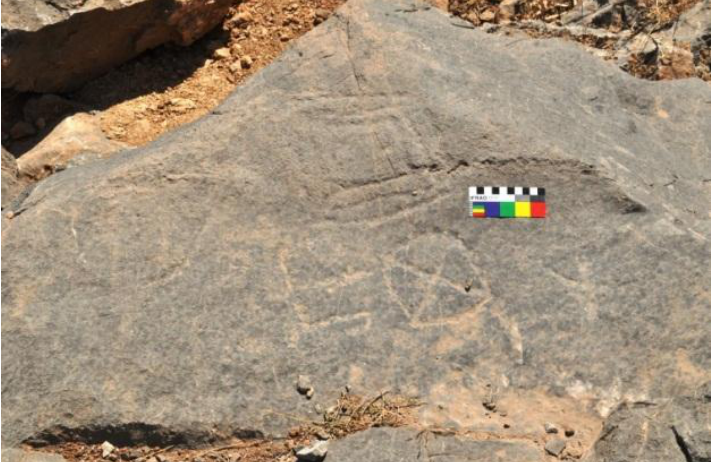
Figure 9. Ghārā-Tepe I, panel 6, geometric markings.